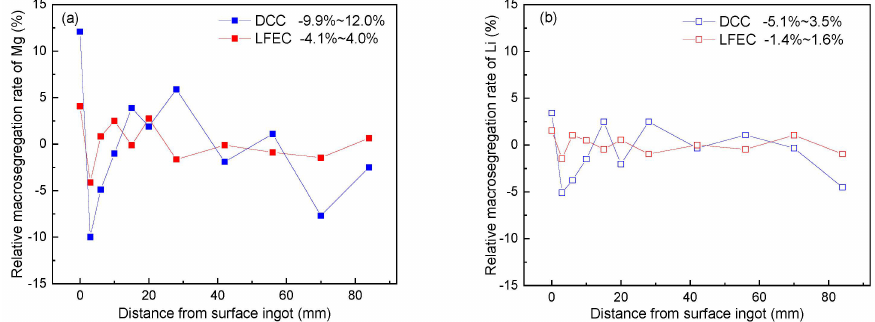
Figure 4. Relative segregation rate of alloying element of 5A90 ingots cast by DCC and LFEC with 10 Hz / 100 A. ( a ) Mg; ( b ) Li.